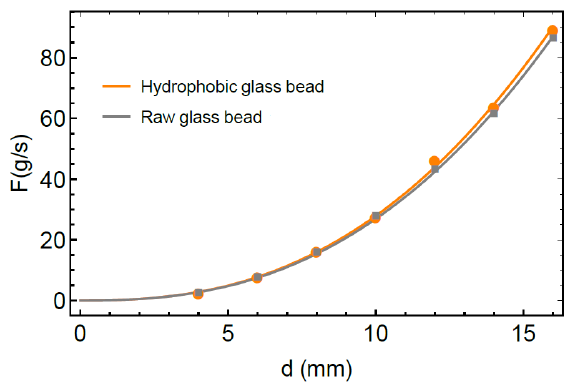
Figure 3. Fit of the Eq. (1) on the data for respectively the raw bead, in grey, and hydrophobic bead, in orange. The humidity and temperature range are 37-44 % and 22 ◦ C, respectively.